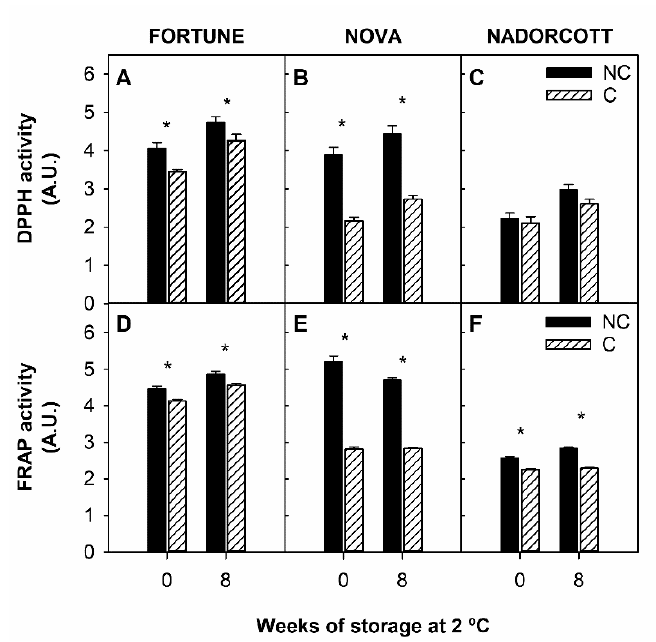
Figure 4. DPPH • antioxidant activity in the peel of non-covered (NC) and covered (C) fruit of Fortune ( A ), Nova ( B ), and Nadorcott ( C ); FRAP antioxidant activity in the peel of non-covered (NC) and covered (C) fruit of Fortune ( D ), Nova ( E ), and Nadorcott ( F ), at harvest (0) and after 8 weeks of storage at 2 °C. Asterisk indicates significant differences between NC and C fruit for each cultivar and sample date ( p ≤ 0.05 , t- test).